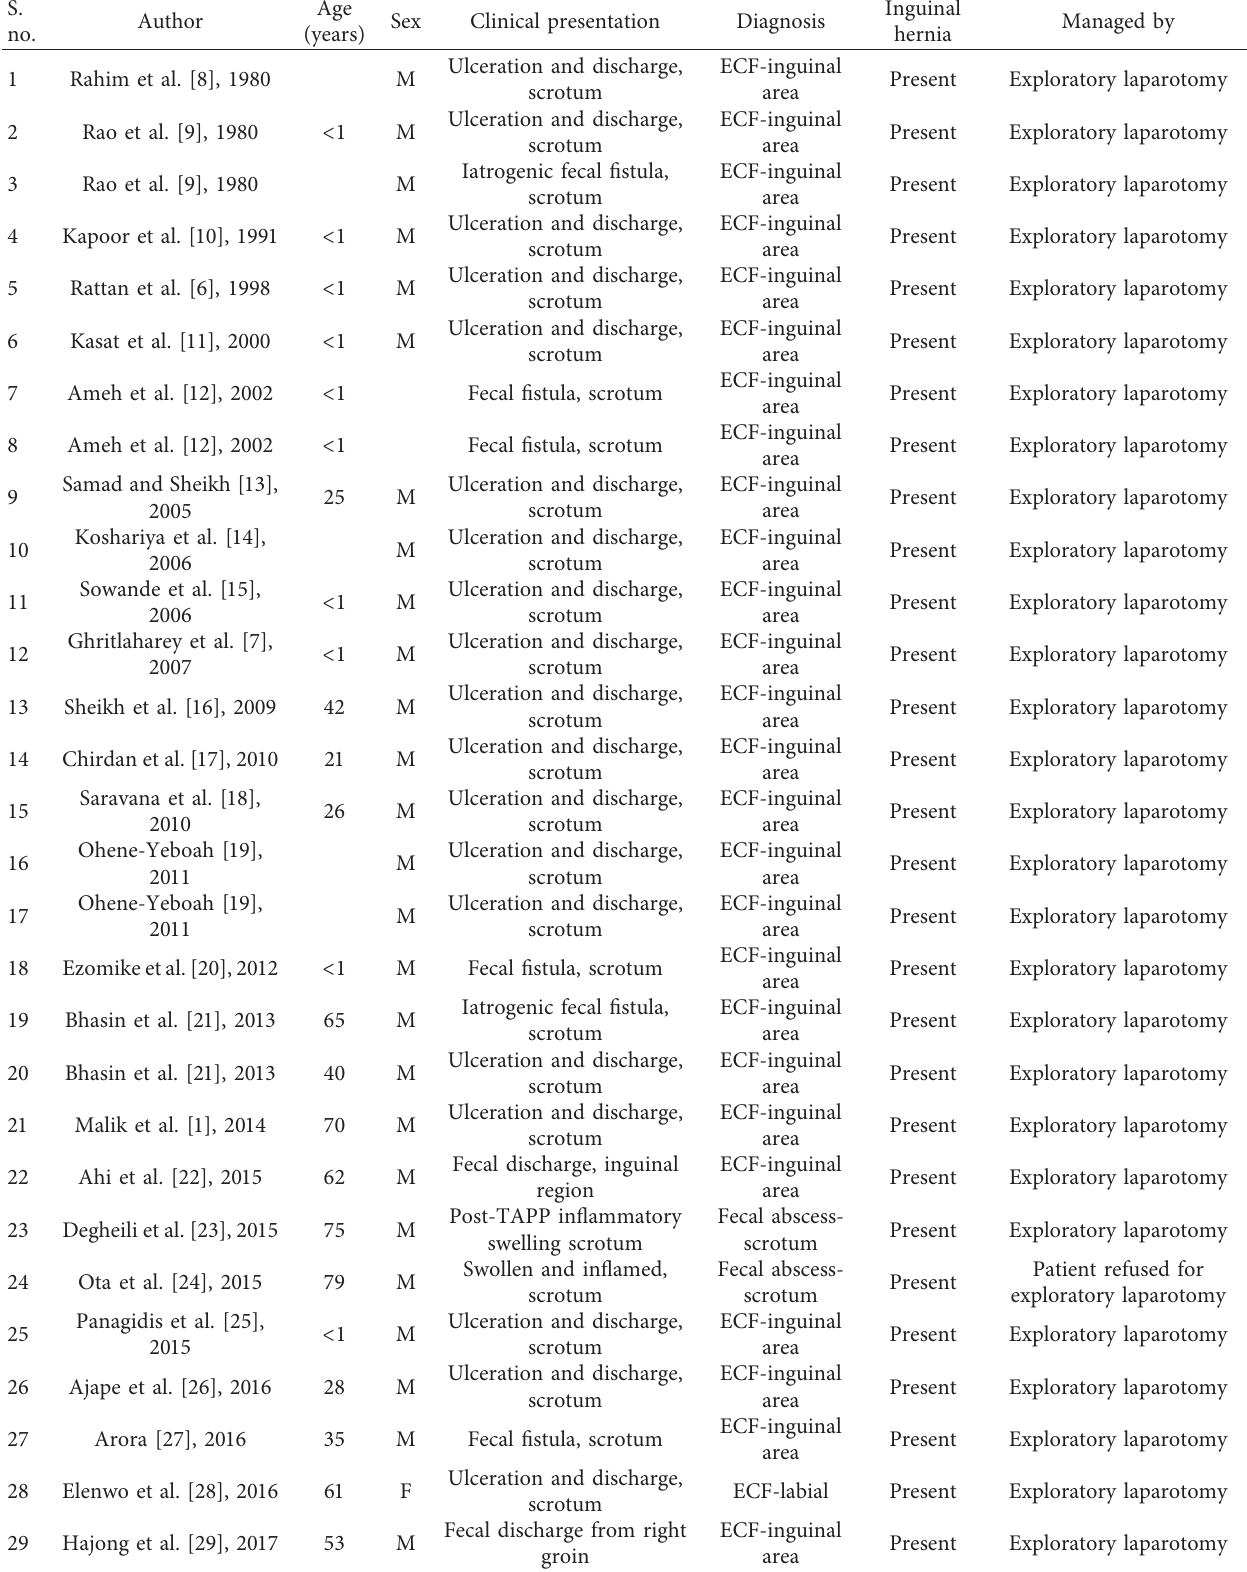
Table 1: Review of literature of enterocutaneous fistula (ECF)/fecal abscess of the scrotum.